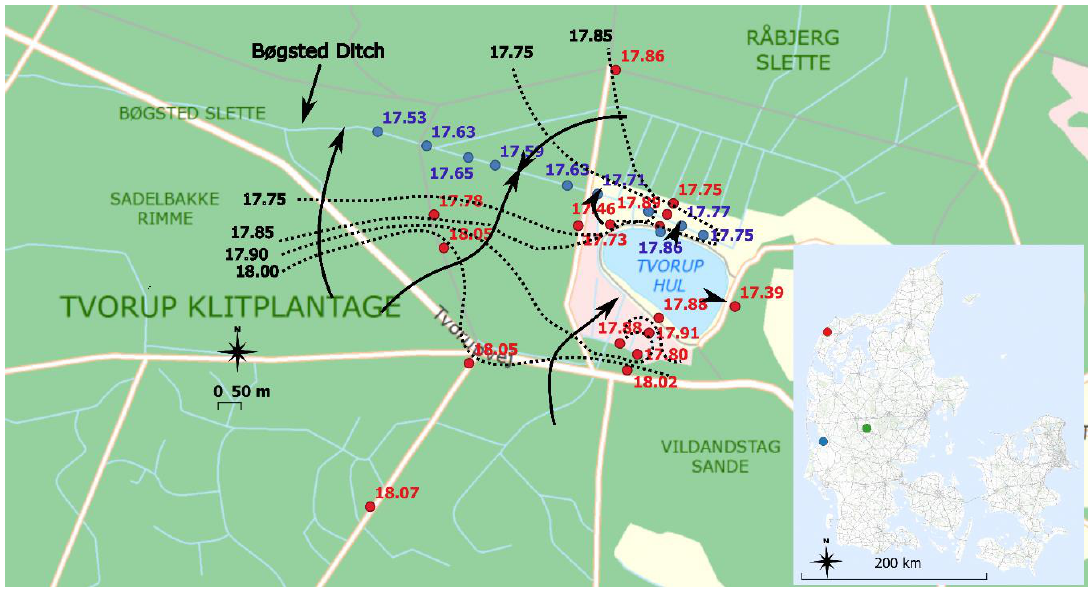
Figure 1. Iso-potential map (black dashed line) and estimated flow paths (solid lines with arrows, the two arrow heads on the east and north side of the lake show recharge or outflow from the lake). Red circles with the value show the measured hydraulic head. Blue circles with the value show the measured stage in Bøgsted Ditch and Lake Tvorup Hul (17.86 m). All data are from August 2017. Pine tree plantation with small drainage ditches (green), heath area (pink), and grass land (light brown). Inset shows the location of Lake Tvorup Hul in Denmark (red dot, UTM zone 32, 467400E; 6314280N), Skjern Enge δ 18 O precipitation station (blue dot, UTM zone 32, 463000E, 6196000N), and Voulund precipitation station, where Electrical Conductivity (EC) in rain was measured (green dot, UTM zone 32, 510013E, 6210233N).